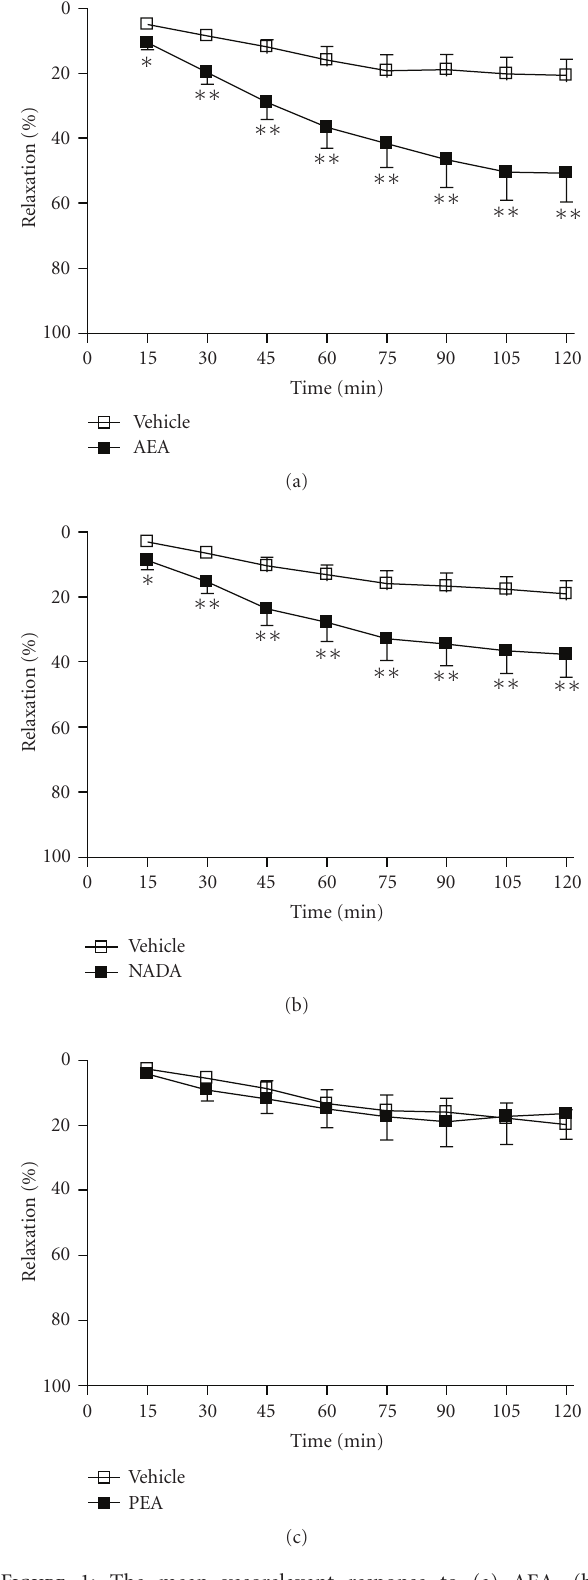
Figure 1: The mean vasorelaxant response to (a) AEA, (b) NADA, and (c) PEA versus vehicle (0.1% EtOH) over 2 hours in preconstricted aortae. Data are given as means with error bars representing SEM. ( ∗ P < . 05, ∗∗ P < . 01, Student’s t -test, n =